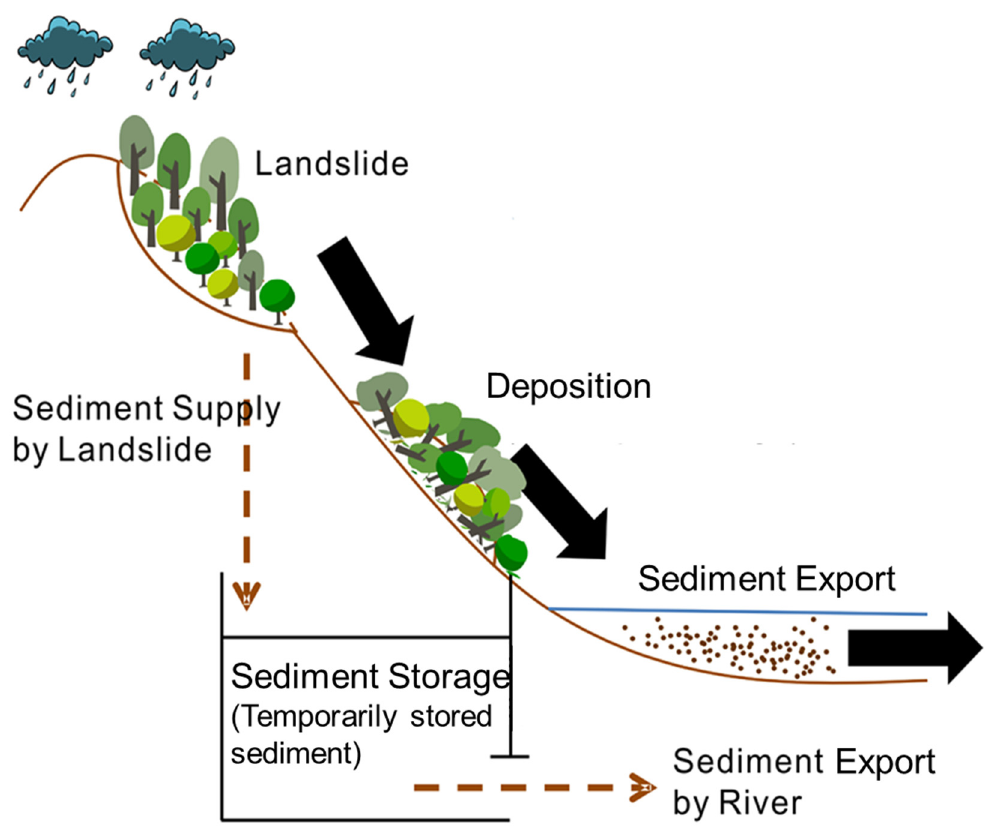
Figure 1. Schematic diagram of sediment transport from landslide to river. Two coupled models, i.e., landslide model and sediment transport model, were proposed in this study. Landslide-generated sediment is firstly added to the sediment storage (the vertical dashed arrow) before washing off by river (the horizontal dashed arrow).